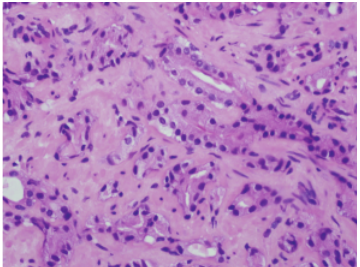
Figure 2: Prostate adenocarcinoma from biopsy (hematoxylin and eosin, 400x).